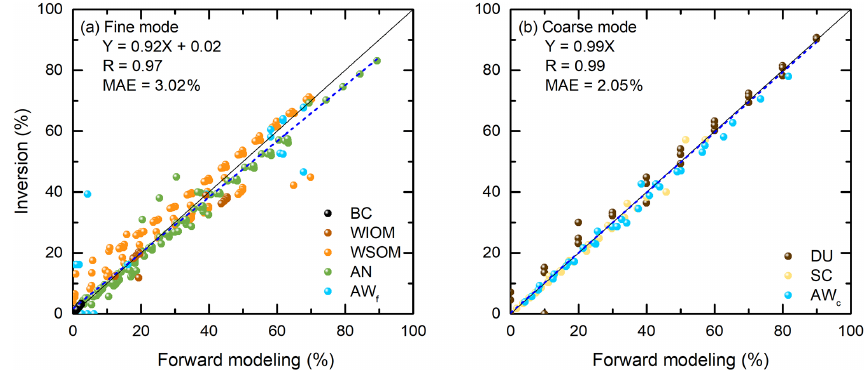
Figure 5. Scatterplots of volume fractions of aerosol components in the fine (a) and coarse (b) modes retrieved using the algorithm described in Sect. 3 versus those used as input calculated with the forward model. The solid line is the 1 : 1 line, and the dashed line is the fitting line.